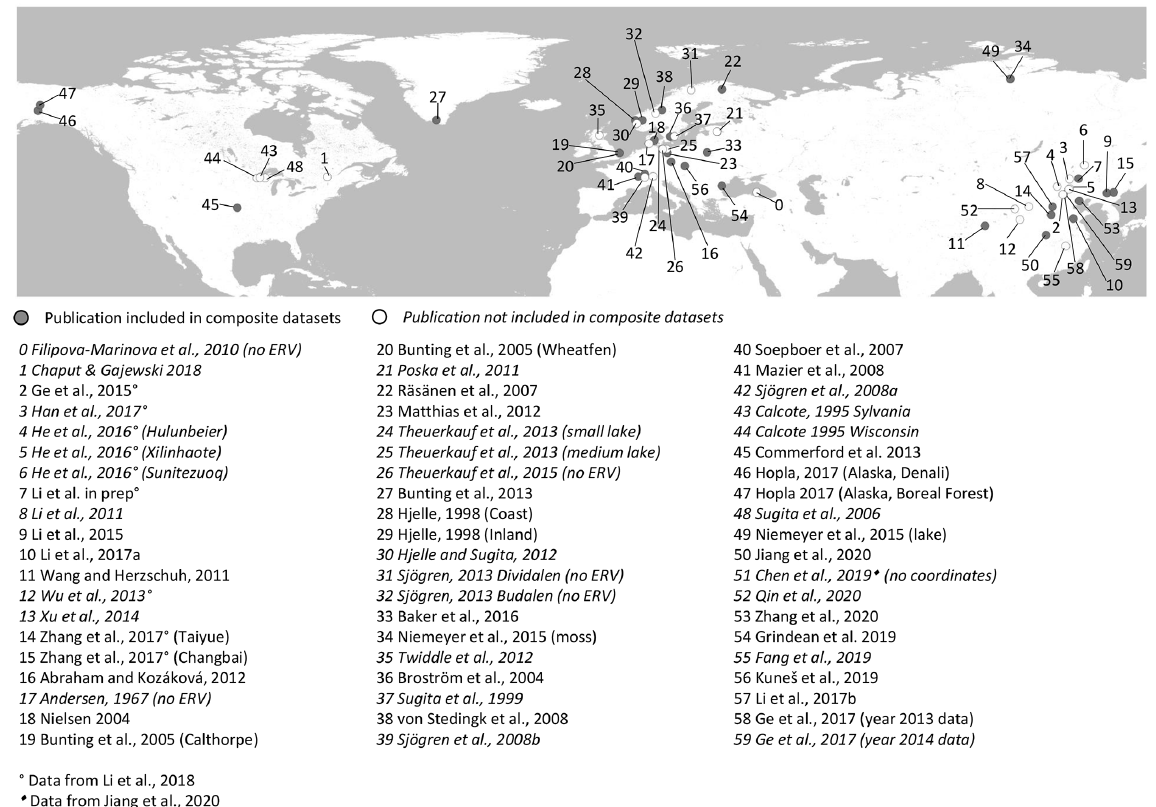
Figure 1. Map of Northern Hemisphere studies on relative pollen productivity estimates. Studies in italics are not included in the continental relative pollen productivity